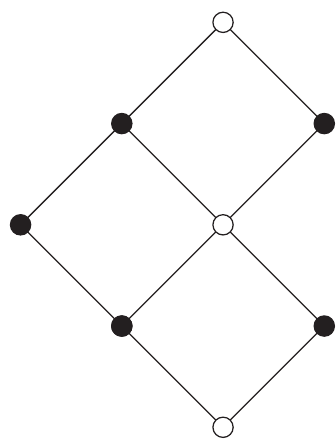
Figure 2: Hasse diagram of DM (𝑃 4 )